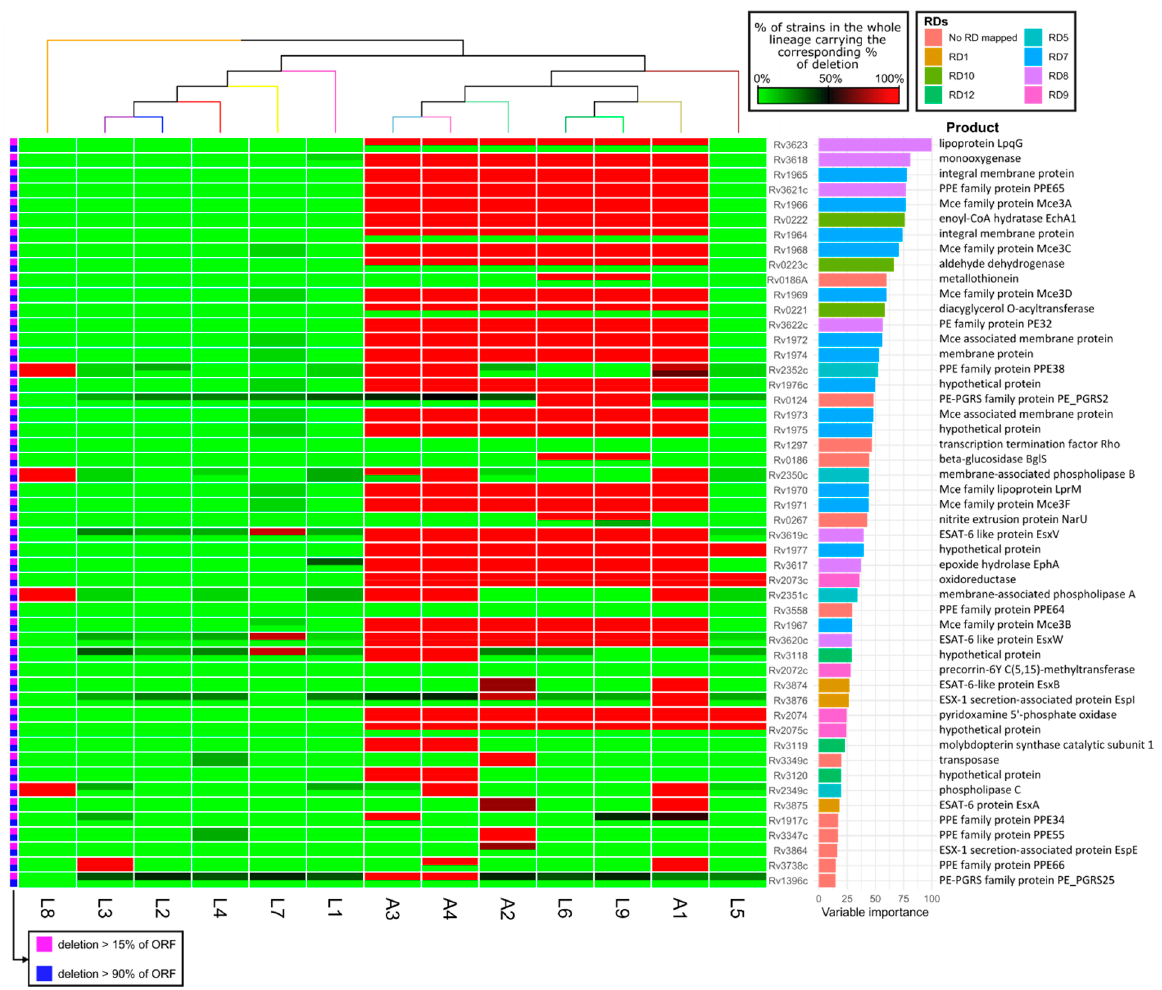
Figure 3. Supervised analysis of the deletion data. Random forest of the percentage of each ORF from the reference genome that was lost in each lineage, classifying the genomes as belonging to animal- or human-associated lineages. The variables (genes) are sorted according to their importance in the classification (rightmost barplot), and are colored depending on the RD they are located in. RDs are named according to Brosch et al. 2002. The heatmap corresponds to the percentage of isolates with a percentage of deletion higher of the 15% or 90% (magenta or blue, respectively, indicated in leftmost colorbar).